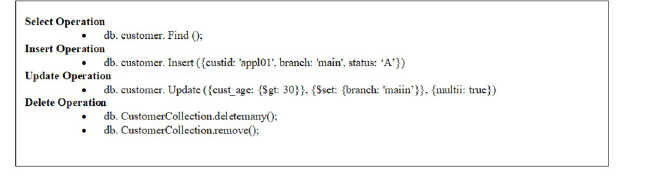
Fig 4. Mongo libraries.